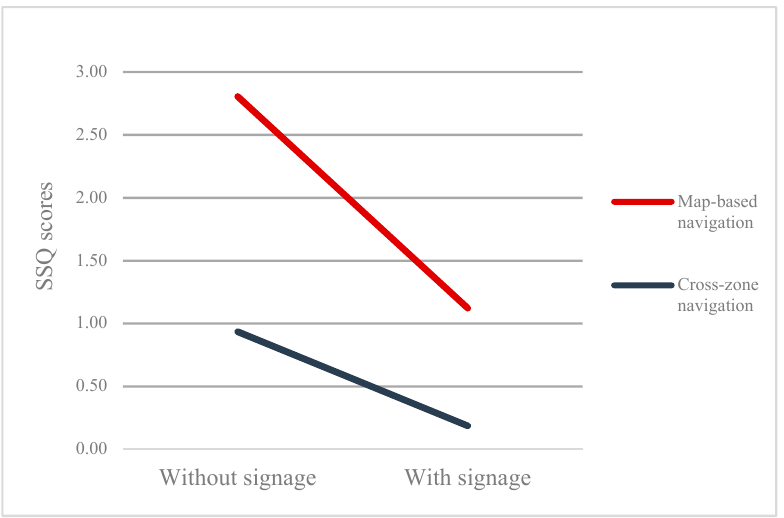
Figure 11. Interaction effect between navigation system and signage system on SSQ.